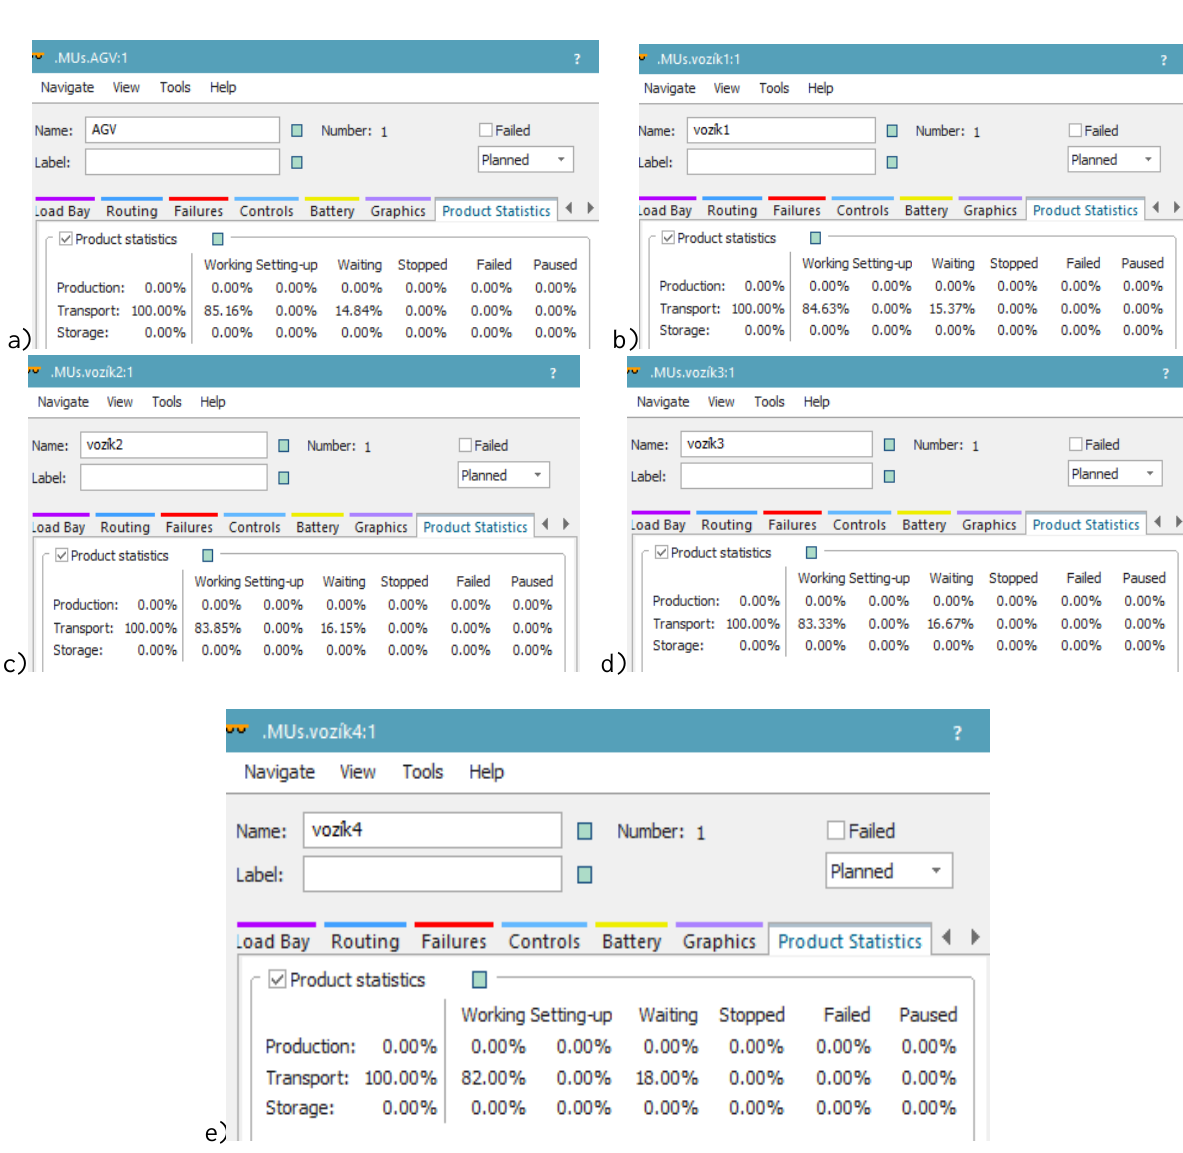
Figure 6: Statistical occupancy of the “AGV” vehicle and “transporters” by cancelling of three